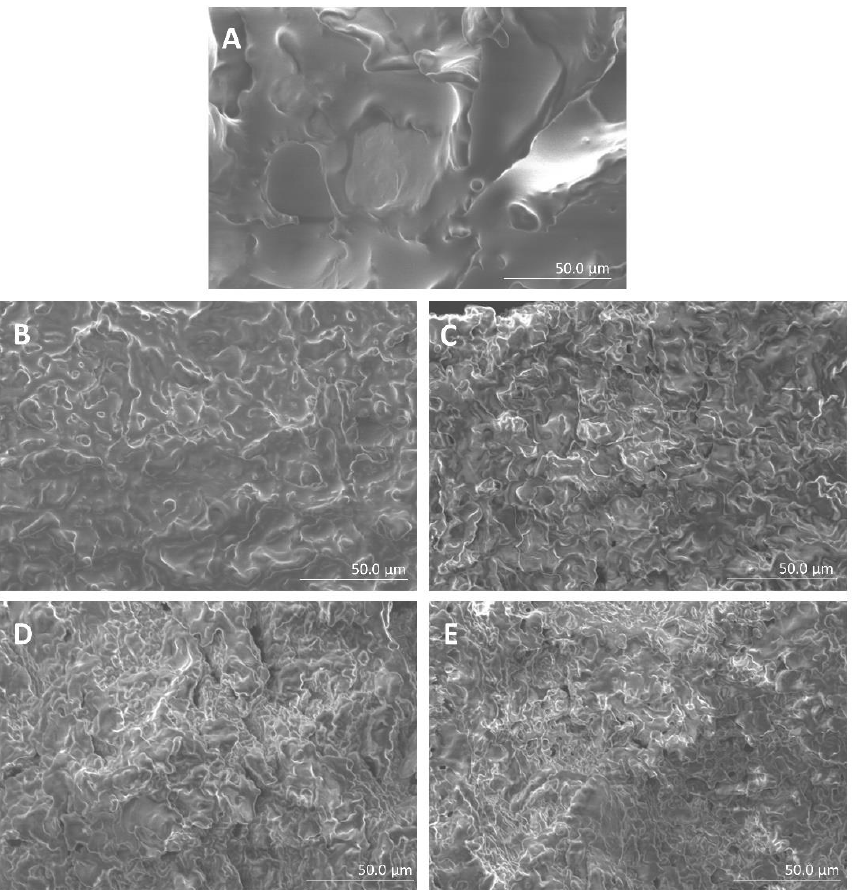
Figure 2. Scanning electron microscopy analysis of the emulsion gels. Scanning electron micrographs of the konjac emulsion gels supplemented with cyclodextrin (CD; 0–8%, w / w ) (magnification = 800 × , n = 3). ( A ) CD0, 0% CD-supplemented konjac-based emulsion gel; ( B ) CD2, 2% CD-supplemented konjac-based emulsion gel; ( C ) CD4, 4% CD-supplemented konjac-based emulsion gel; ( D ) CD6, 6% CD-supplemented konjac-based emulsion gel; ( E ) CD8, 8% CD-supplemented konjac-based emulsion gel.